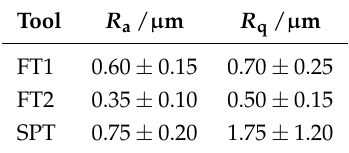
Table 2. Surface roughness of specimens surface-machined with different